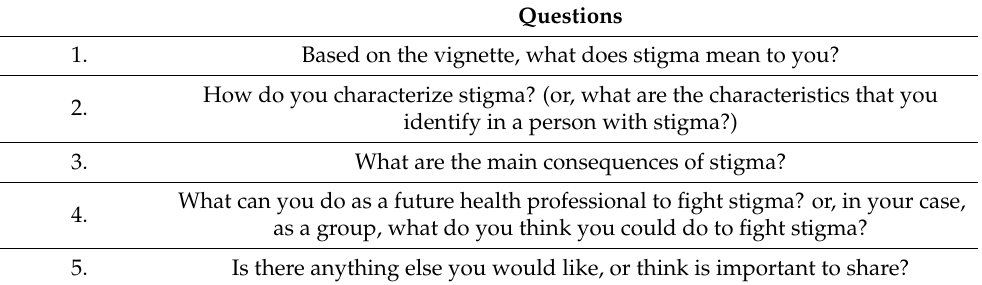
Table 1. Questions of the FG guide